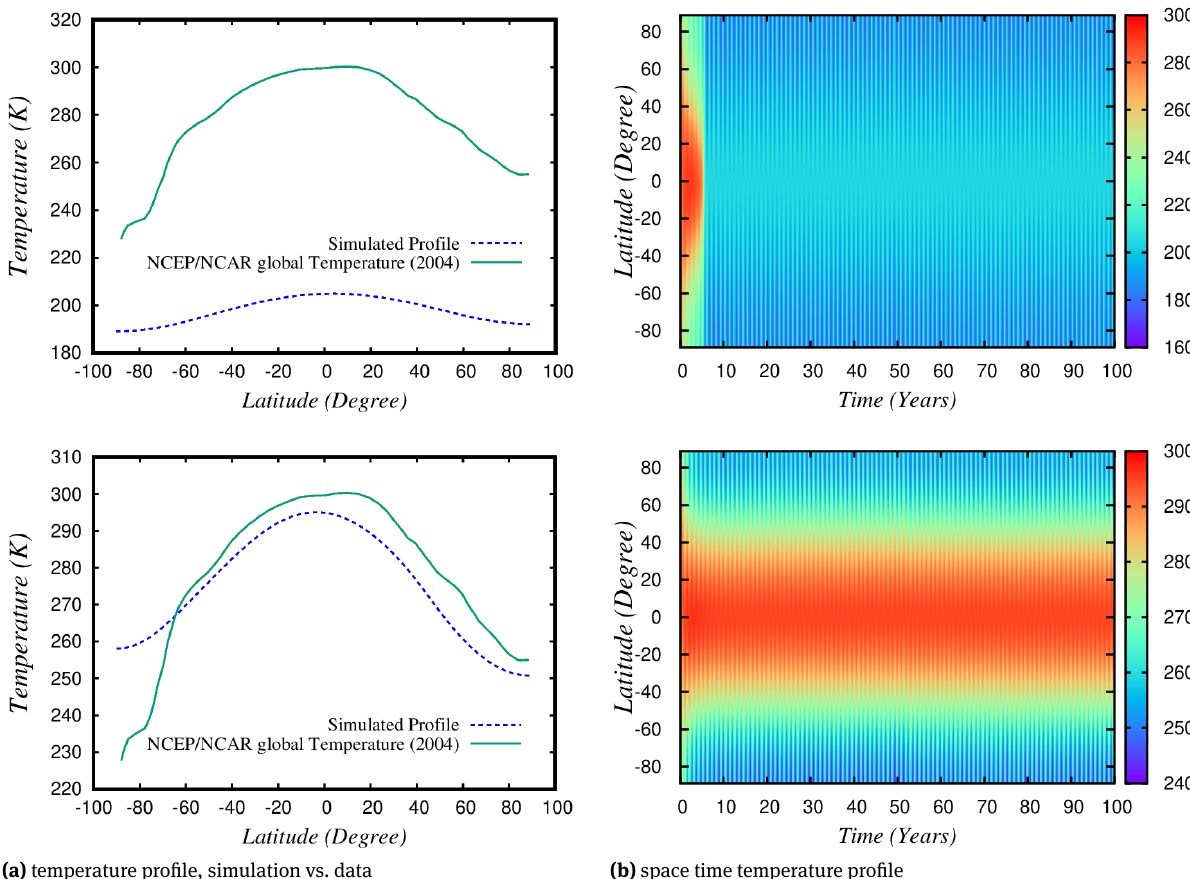
Figure A2. Temperature profile of the Earth when its distance to the Sun is changes from 1 A.U. to 1.025 A.U. Top row: Global freezing using albedo in Spiegel et al. (2009). Bottom row: No global freezing happened using albedo in equation